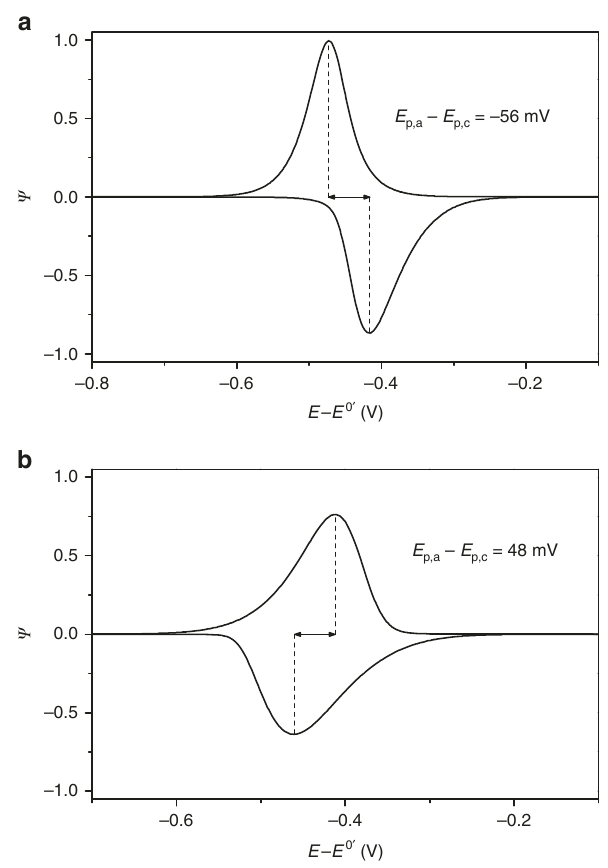
Fig. 4 Kinetic factors mask the inversion of peak potentials and the true peak dispersion. Simulated voltammograms (25 mV s − 1 ) showing the masking of the system ’ s electrostatic (i.e., diode and Frumkin effects) by slow kinetics. Curves are calculated using model 3 and by setting k et to either 100 s − 1 ( a ) or 1 s − 1 ( b ). Frumkin G was + 0.5 and θ is adjusted from 0.04 in the anodic segment to 1.95 in the cathodic one. This increase in θ re fl ects the ca. 50-fold drop in the (photo)hole opposition current ( I L ) generally required to fi t experimental data. The y -axis current is expressed (cid:1) (cid:3) ´ RT = Q Fv ð Þð Þ , with I as ψ ¼ I = I p ; rev F p ; rev being the peak current